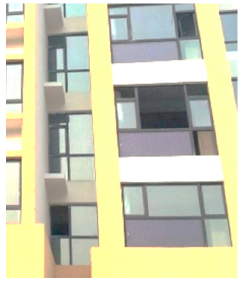
Figure 7. Collectors used as part of the outside windows.